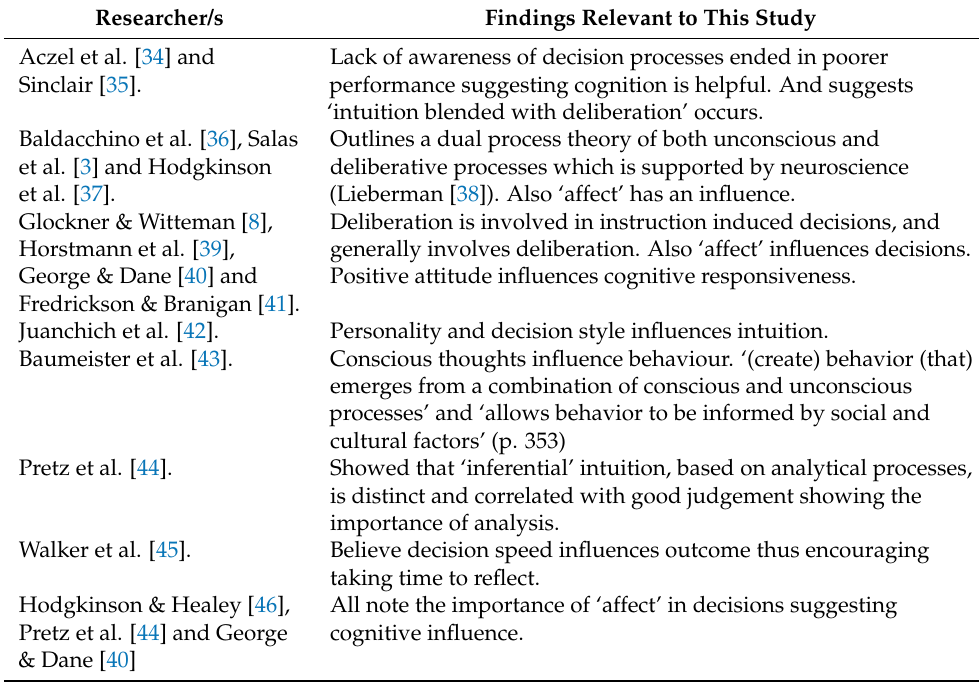
Table 1. Examples of the literature supporting the concept that most intuitive decisions rely on a conscious cognitive input and review where there is a time lapse between observation and the need to